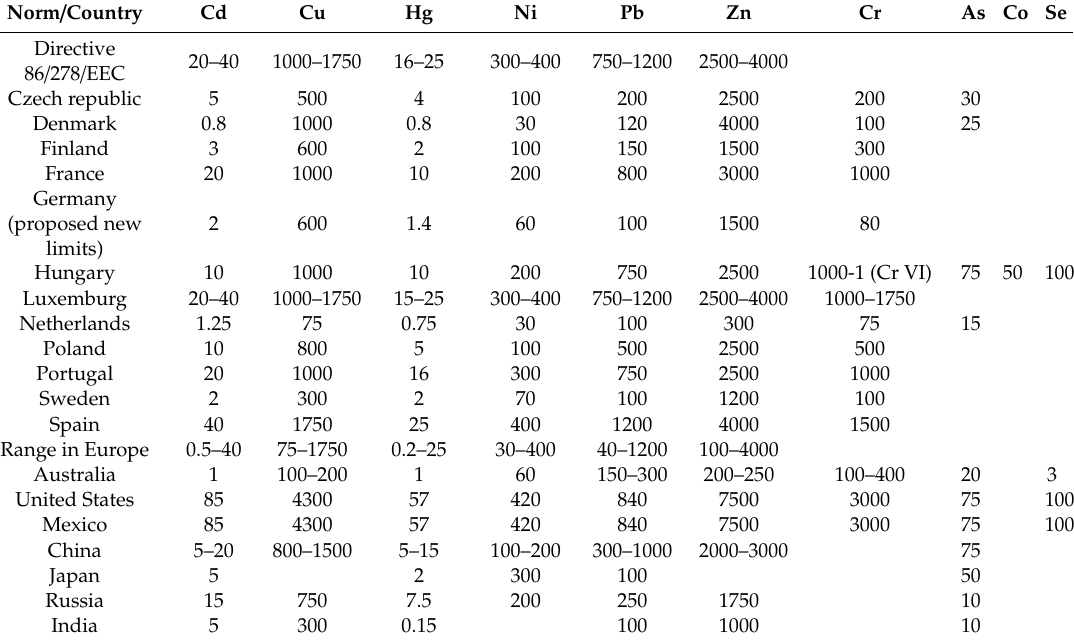
Table 1. Limits of some selected heavy metals in sewage sludge for agricultural use in selected countries [mgkg − 1 DM sewage sludge]